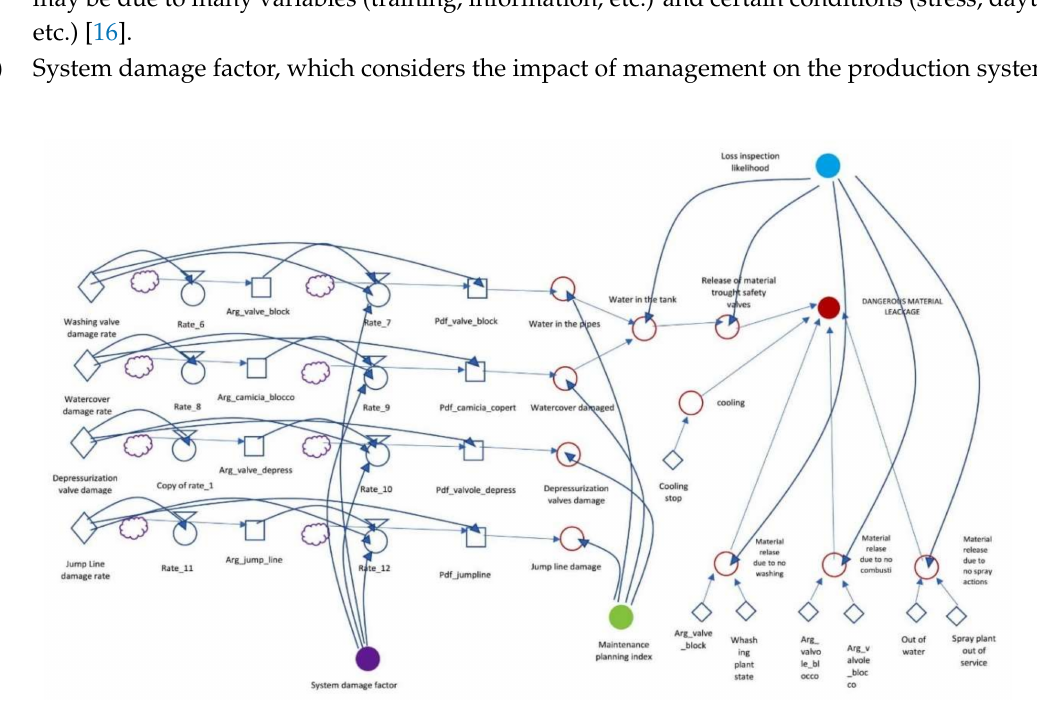
Figure 2. System dynamics diagram of mechanical